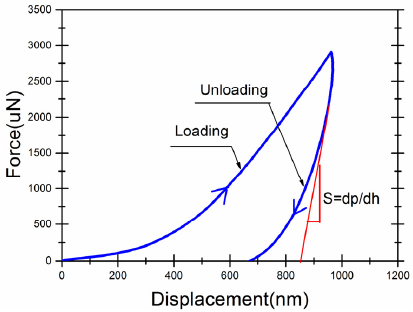
Figure 3. Typical load–displacement curve of nanoindentation and the indent image.